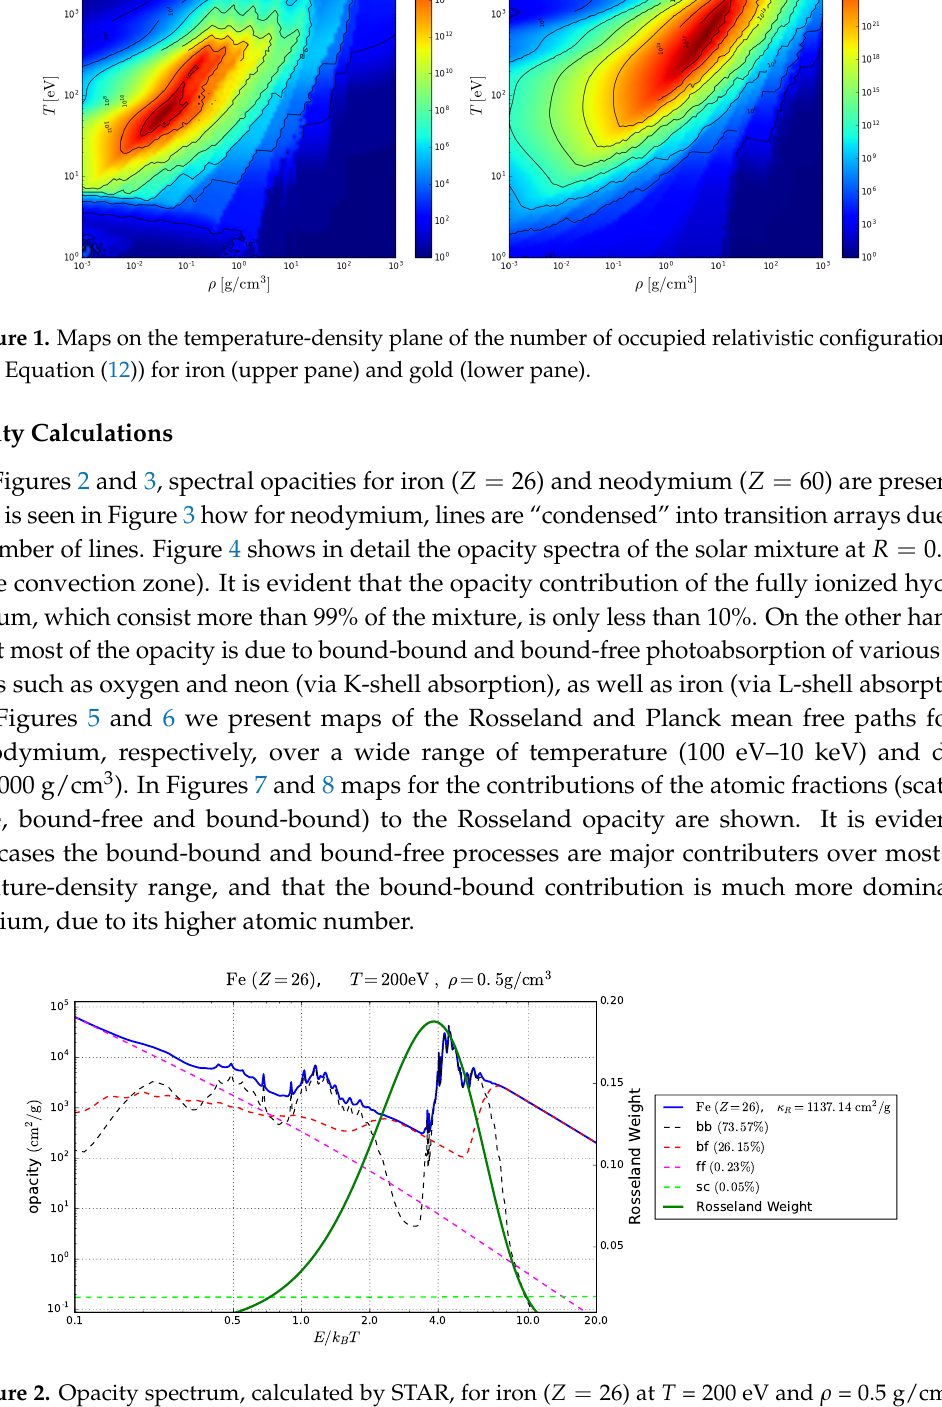
Figure 2. Opacity spectrum, calculated by STAR, for iron ( Z = 26) at T = 200 eV and ρ = 0.5 g/cm 3 . The total (blue), as well as the bound-bound (black), bound-free (red), free-free (magenta) and scattering (lime) opacity spectra are shown (left axis), together with the Rosseland wieght function (green, right axis). The Rosseland mean opacity and the processes contributions to it, are given in the